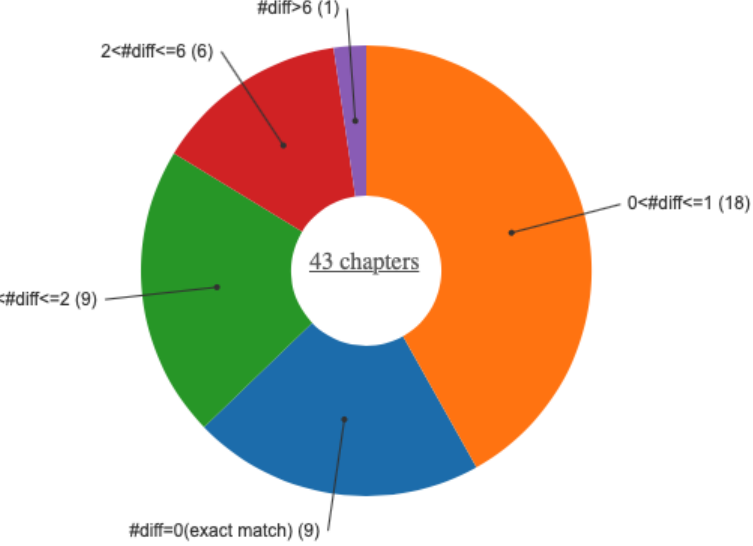
Figure 6. Pie chart of the chapter distribution of Basque translation compared with the original English